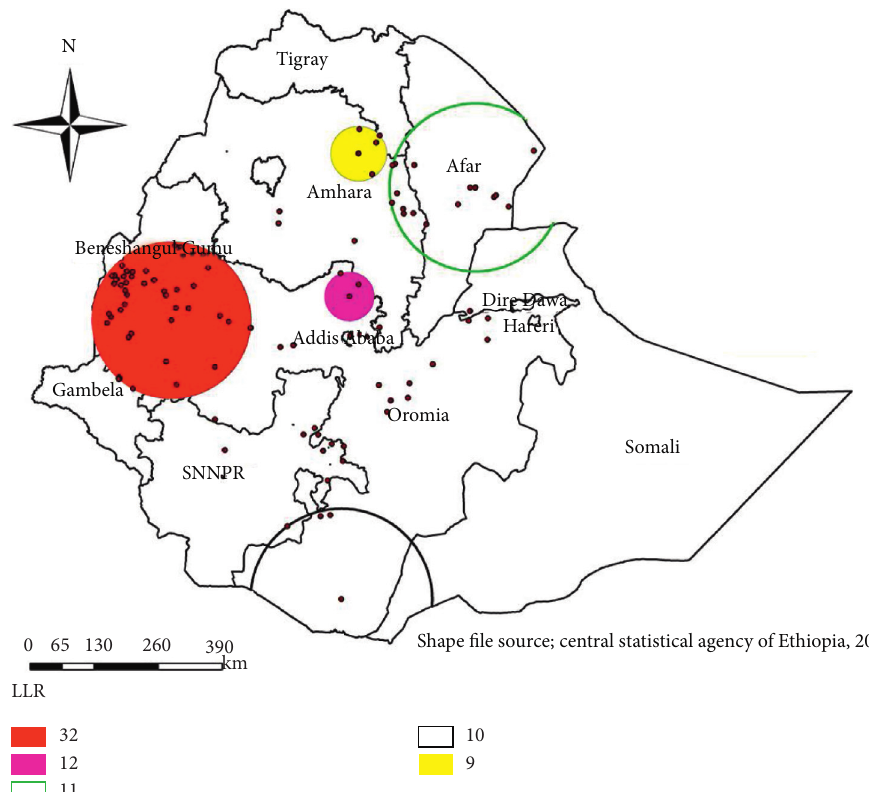
Figure 2: Spatial scan statistics of women’s nonautonomy on decision regarding contraceptive utilization, Ethiopia, 2016. Table 2: The spatial scan statistical analysis of women’s decision-making nonautonomy on contraceptive utilization, Ethiopia, 2016. Cluster type Number of significant enumeration areas Coordinates/radius Populations Cases RR LLR P value